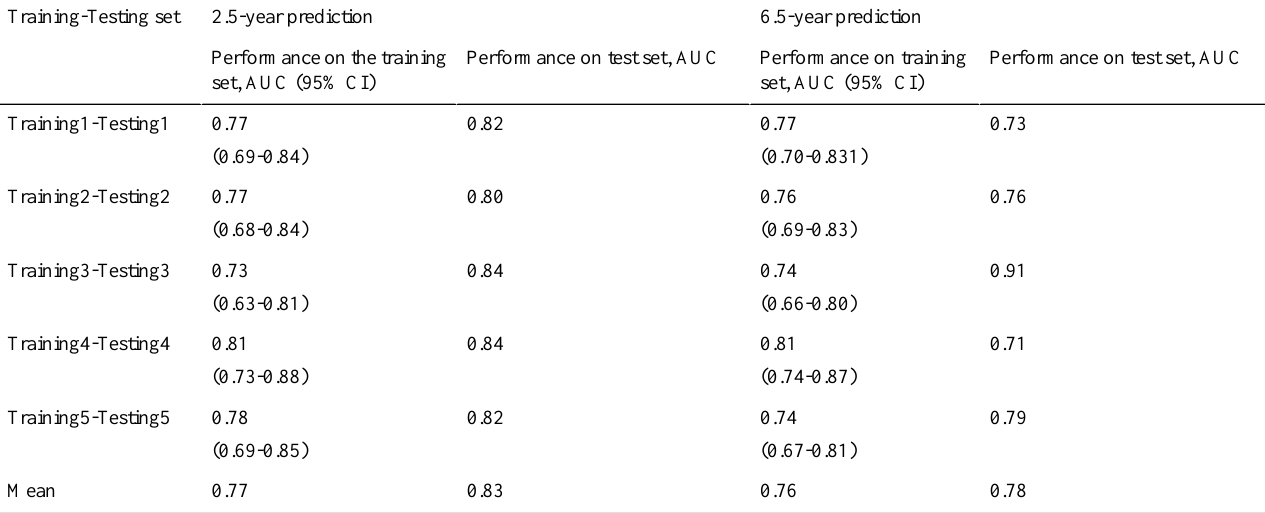
Table 2. Areas under the receiver operating characteristic curves (AUCs) for the 5 training and test sets of the 2 cohorts.